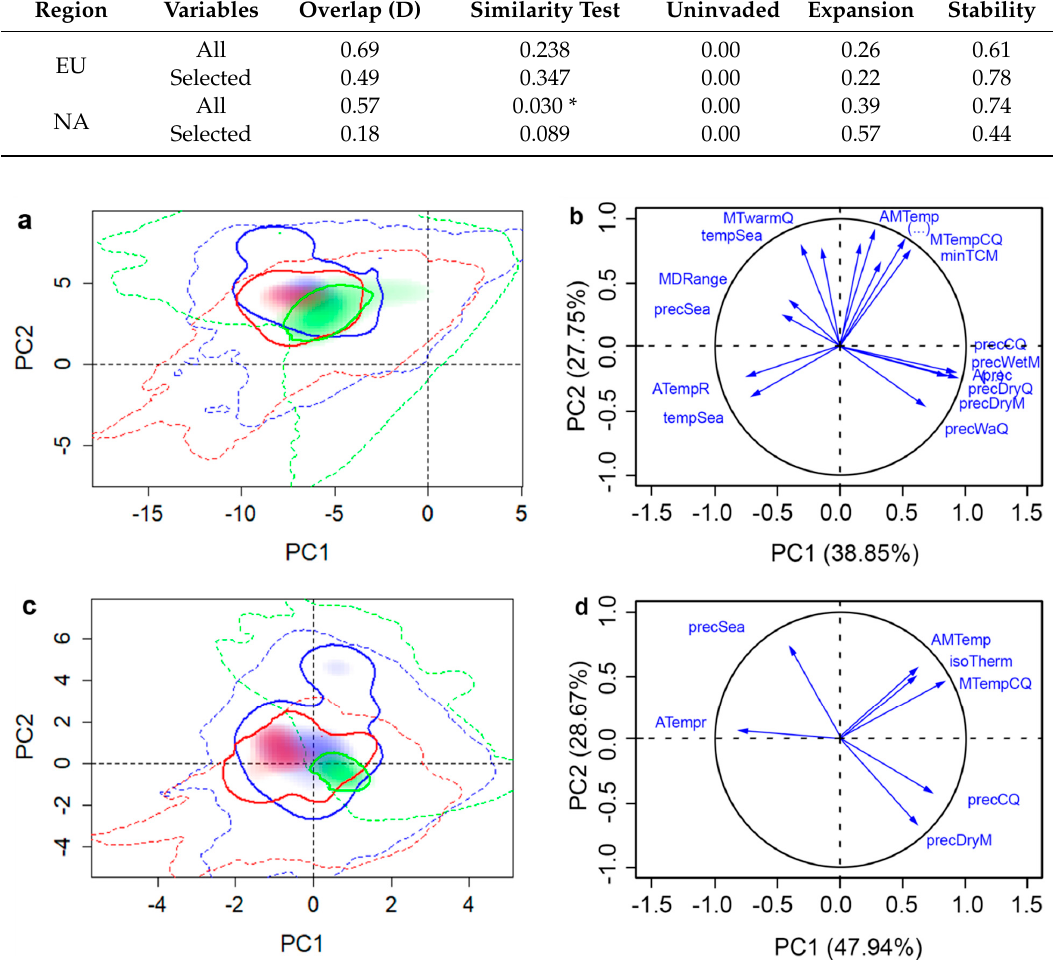
Figure 5. Native and invasive climatic niches of Dutch elm disease in different regions along with variable factor map. Multivariate climatic space was calculated using the PCA-env method. Results using all variables are shown in parts ( a ) and ( b ), whereas parts ( c ) and ( d ) shows the results obtained with selected variables. The solid and dashed lines delineate the niche occupied by the 50% densest population and all available climatic niche, respectively. Shadings correspond to the density of occurrences in each region: Asia (green, native), Europe (red, non-native), and North America (blue, non-native), respectively. The variance explained by the PC1 and PC2 is 66.60% for all variables and 76.61% for selected variables.